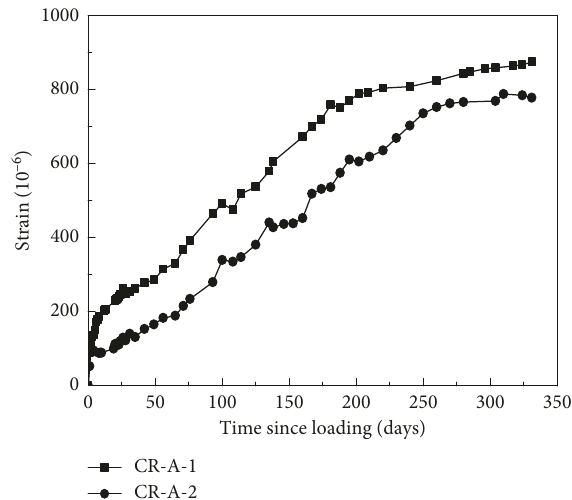
Figure 7: Creep strain curves for specimens CR-A-1 and CR-A-2.